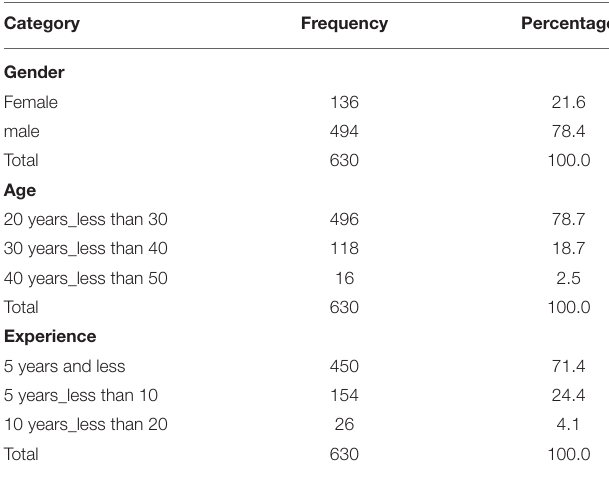
TABLE 1 | Demographic characteristics of the